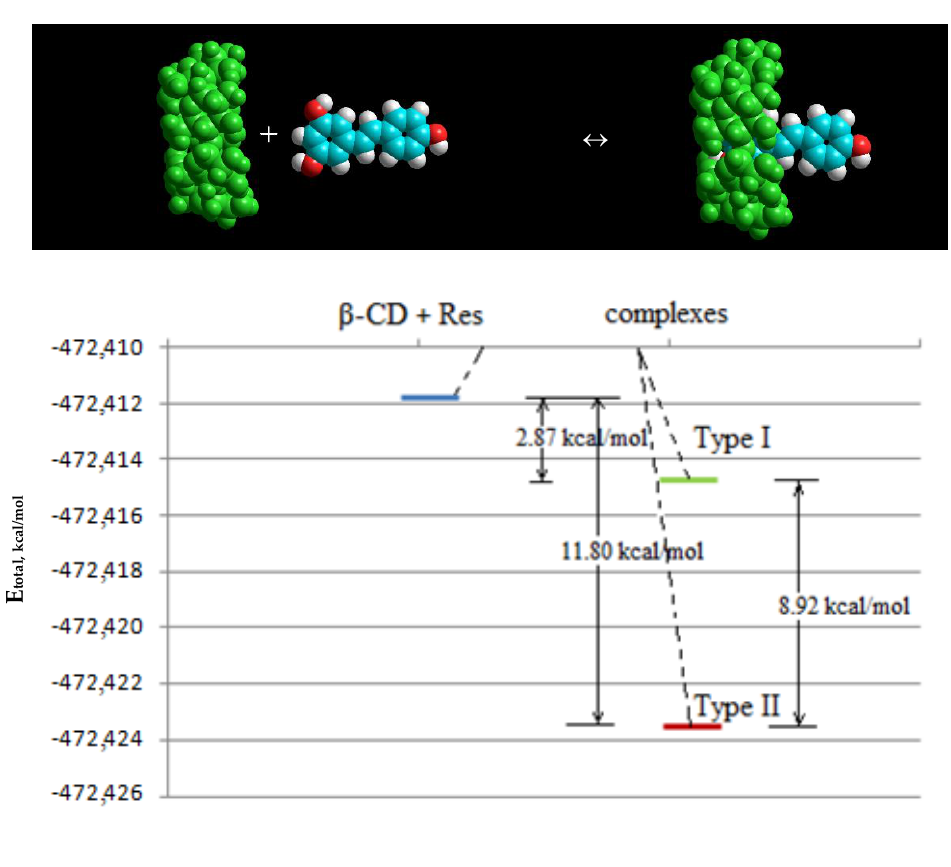
Figure 6. The total amount of energy for the resveratrol –β -CD system before and after complexa- tion